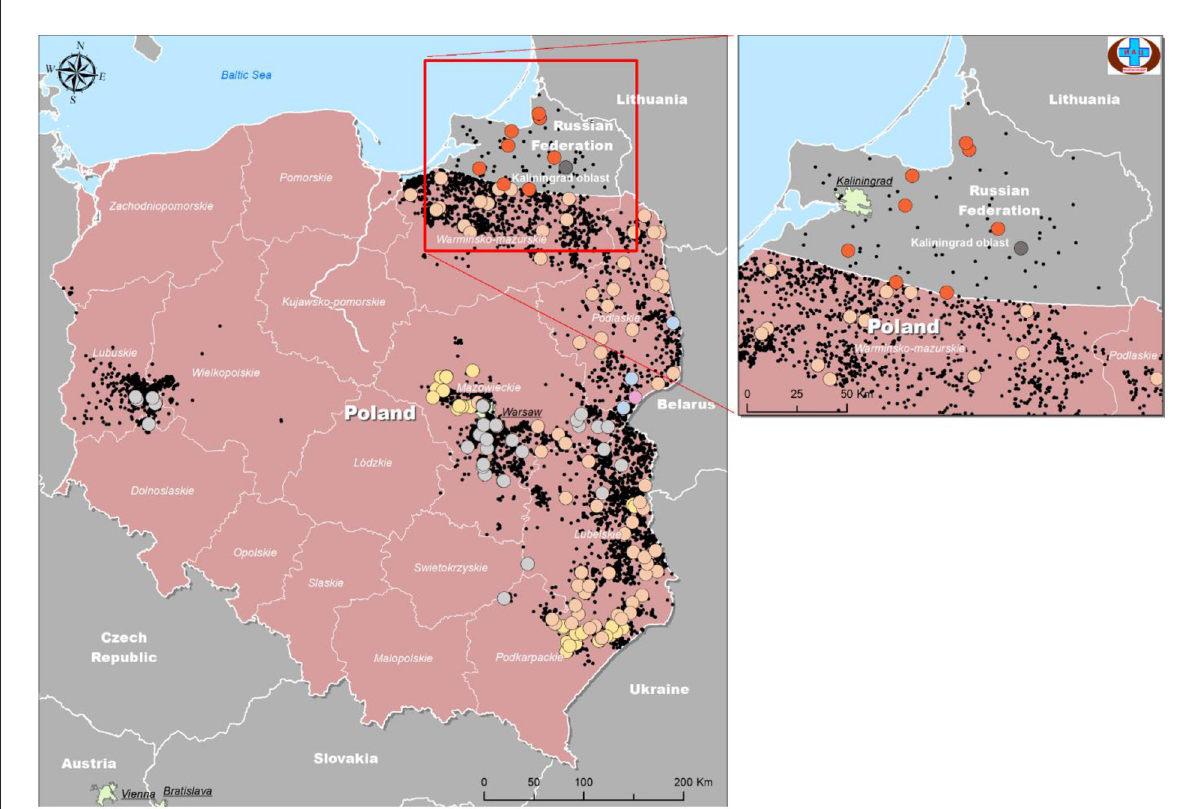
FIGURE6 Geographical distribution of ASFV isolates from Kaliningrad and Poland based on analysis of genome markers IGR (I73R-I329L), O174L, K145R, and MGF